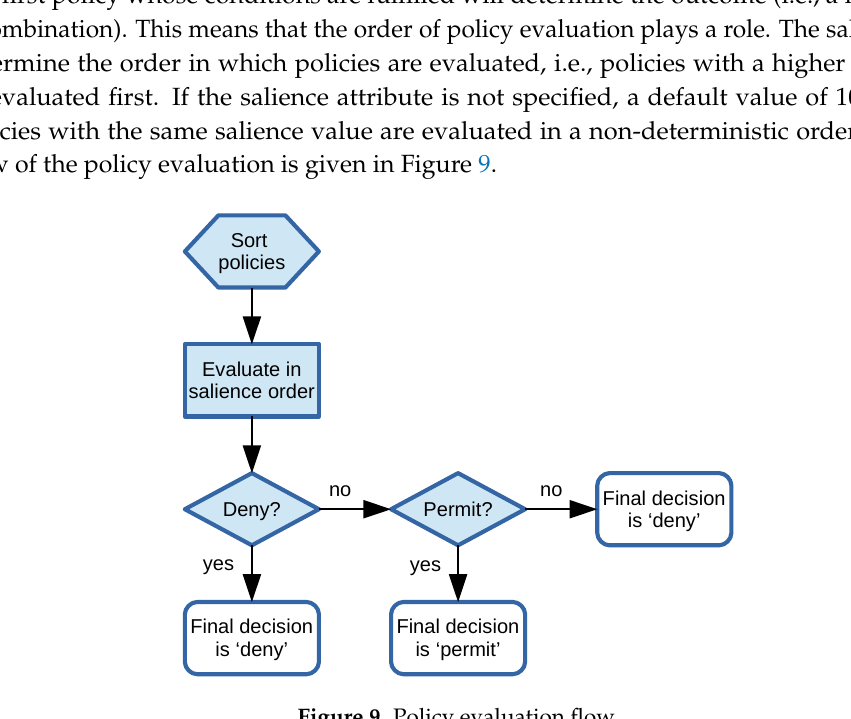
Figure 9. Policy evaluation